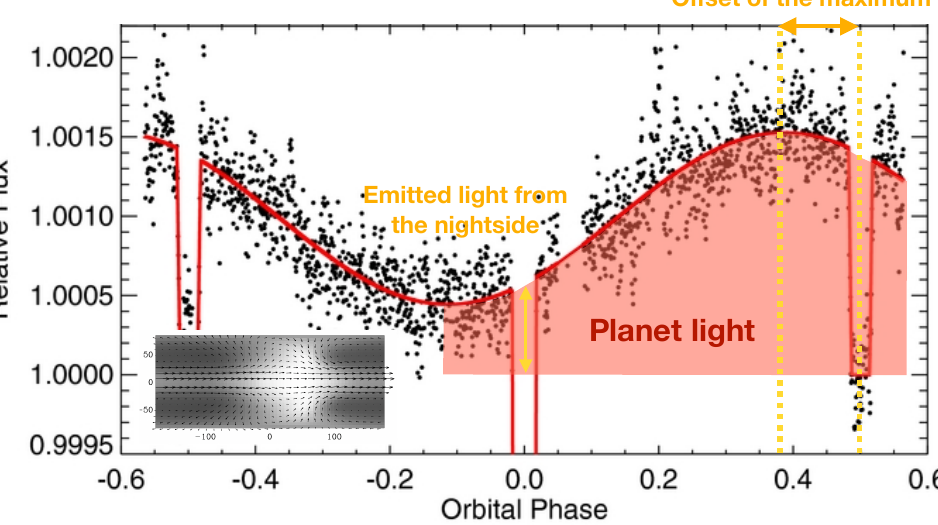
Figure 6. Hot Jupiter HD209458b’s phase curve observed by Spitzer at 4.5 µ m. We show the maximum offset of the phase curve, which is linked to the hot spot offset of the atmosphere. We can deduce the emitted light from the night side looking at the difference between the phase curve if there is no primary transit and the received flux from the star only (i.e., during the secondary eclipse). ( Bottom left ) The longitudinal temperature distribution with the winds (black arrow) from a GCM simulation showing a large equatorial jet and a ∼ 30 ◦ hot spot shift [50]. Figure adapted from